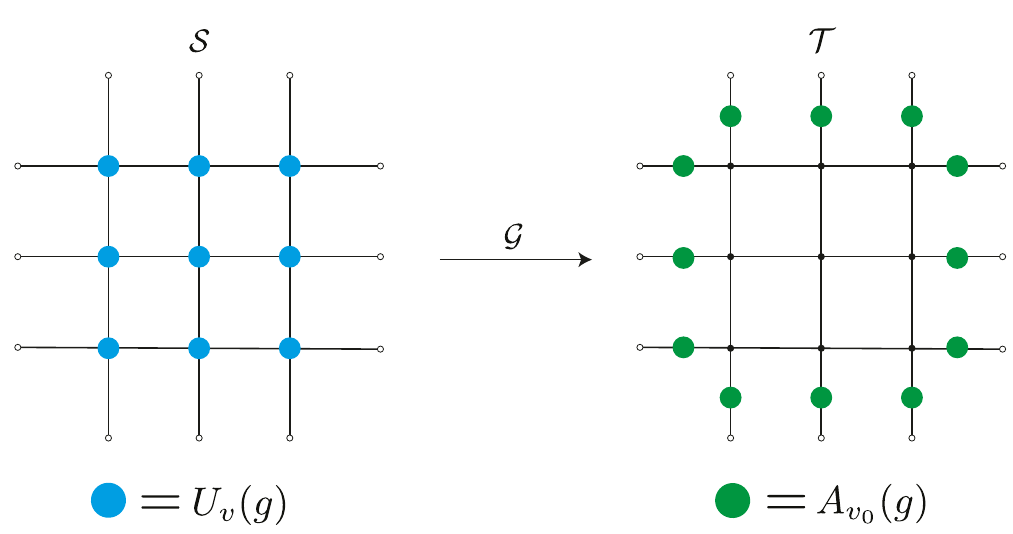
Figure 2. A global symmetry action acting on the input to the gauging map acts as an NGC symmetry transformation acting on its output. Note that we are omitting the action on NGC vertices (represented by white dots) for consistency with future diagrams. This is because for holographic codes we require in the Bulk that all V Hilbert spaces are 0